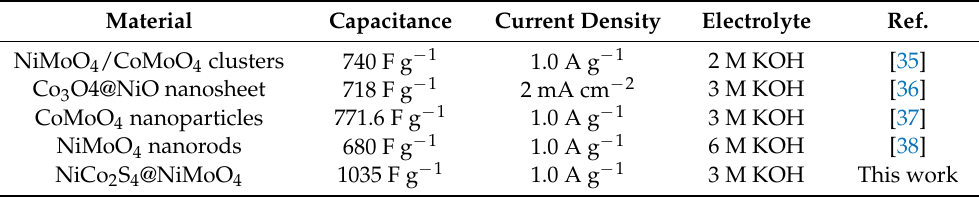
Table 1. Electrocatalytic performance comparison of hybrid structured NiCo 2 S 4 @NiMoO 4 with the reported